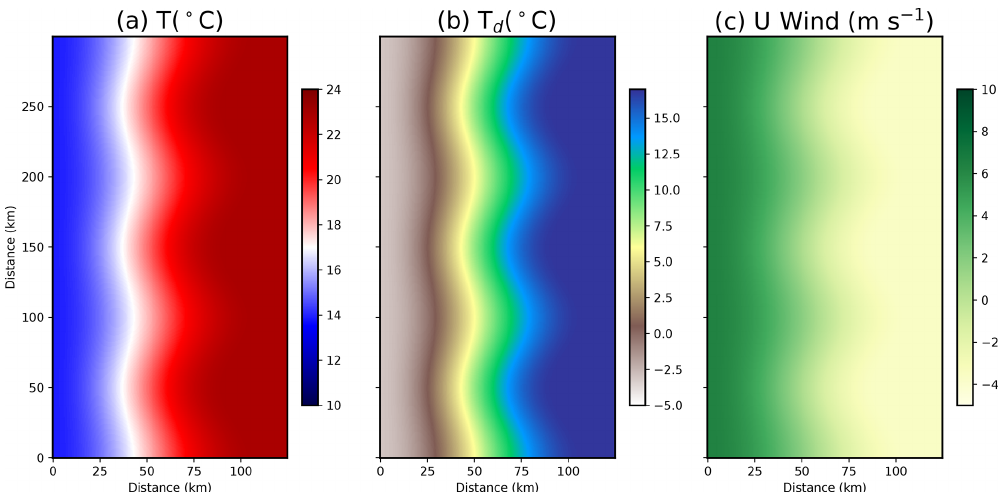
Figure 2. Nature run initial conditions at the lowest model level for (a) T , (b) T d , and (c) u wind. The plotted subdomain is centered on the initial frontal